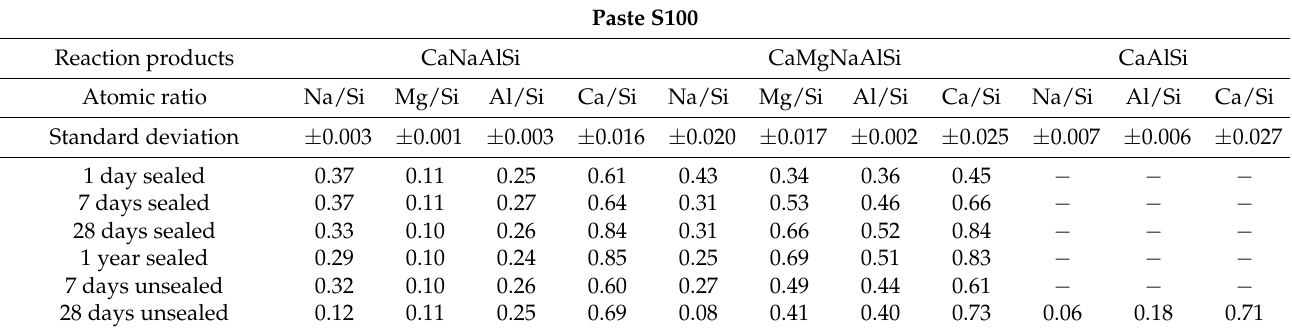
Table 6. Atomic ratios in the reaction products by PARC analysis in pastes S100.